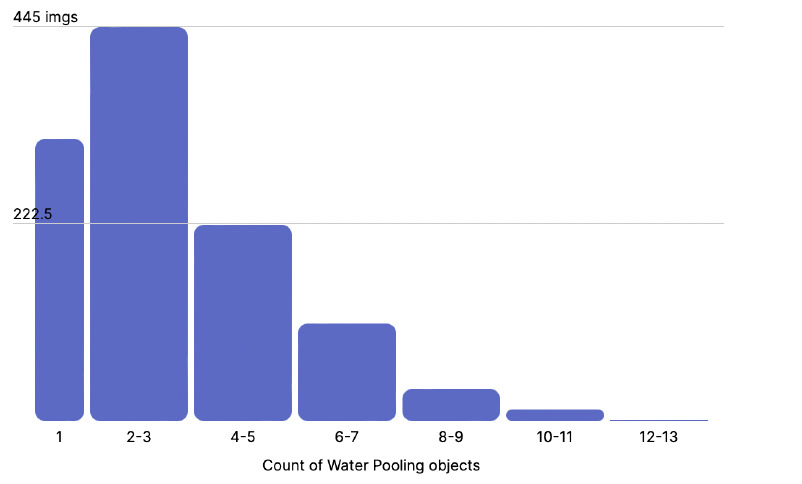
Figure 12. Distribution of water pooling objects per image.